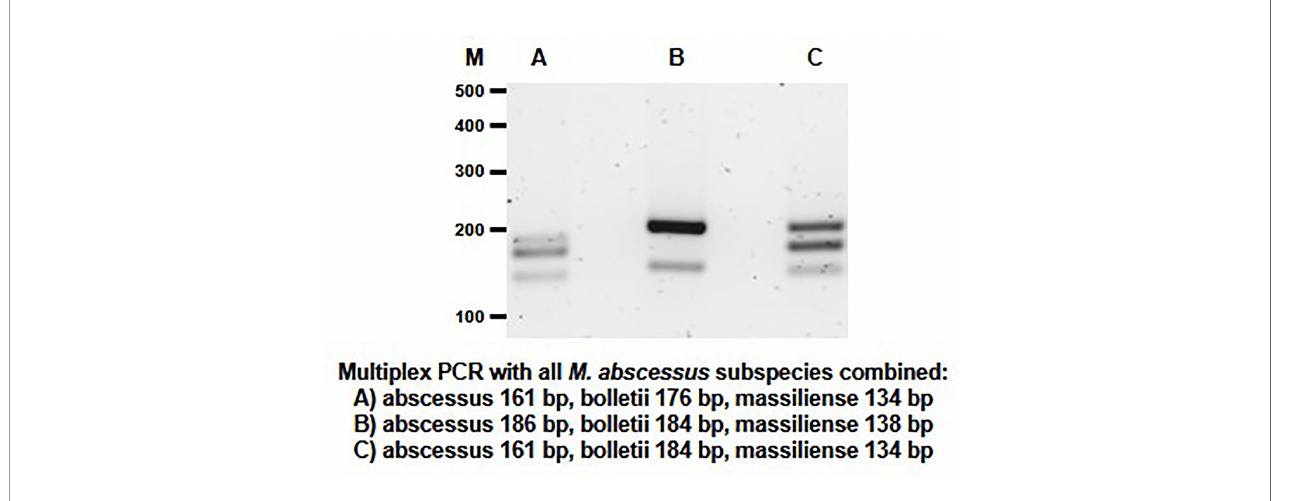
FIGURE 5 | Multiplex PCR assay performed for the detection of the MABC subspecies within a mixed sample. The mixed sample contained the extracted DNA of M. abscessus , M. bolletii , M. massiliense and other bacterial samples ( M. chelonae , M. tuberculosis , M. avium, M. intracellulare, M. chimaera and E. coli) (controls) in the same tube. The PCR products sizes for the MABC subspecies are shown in the multiplex assays (Lane A – C)